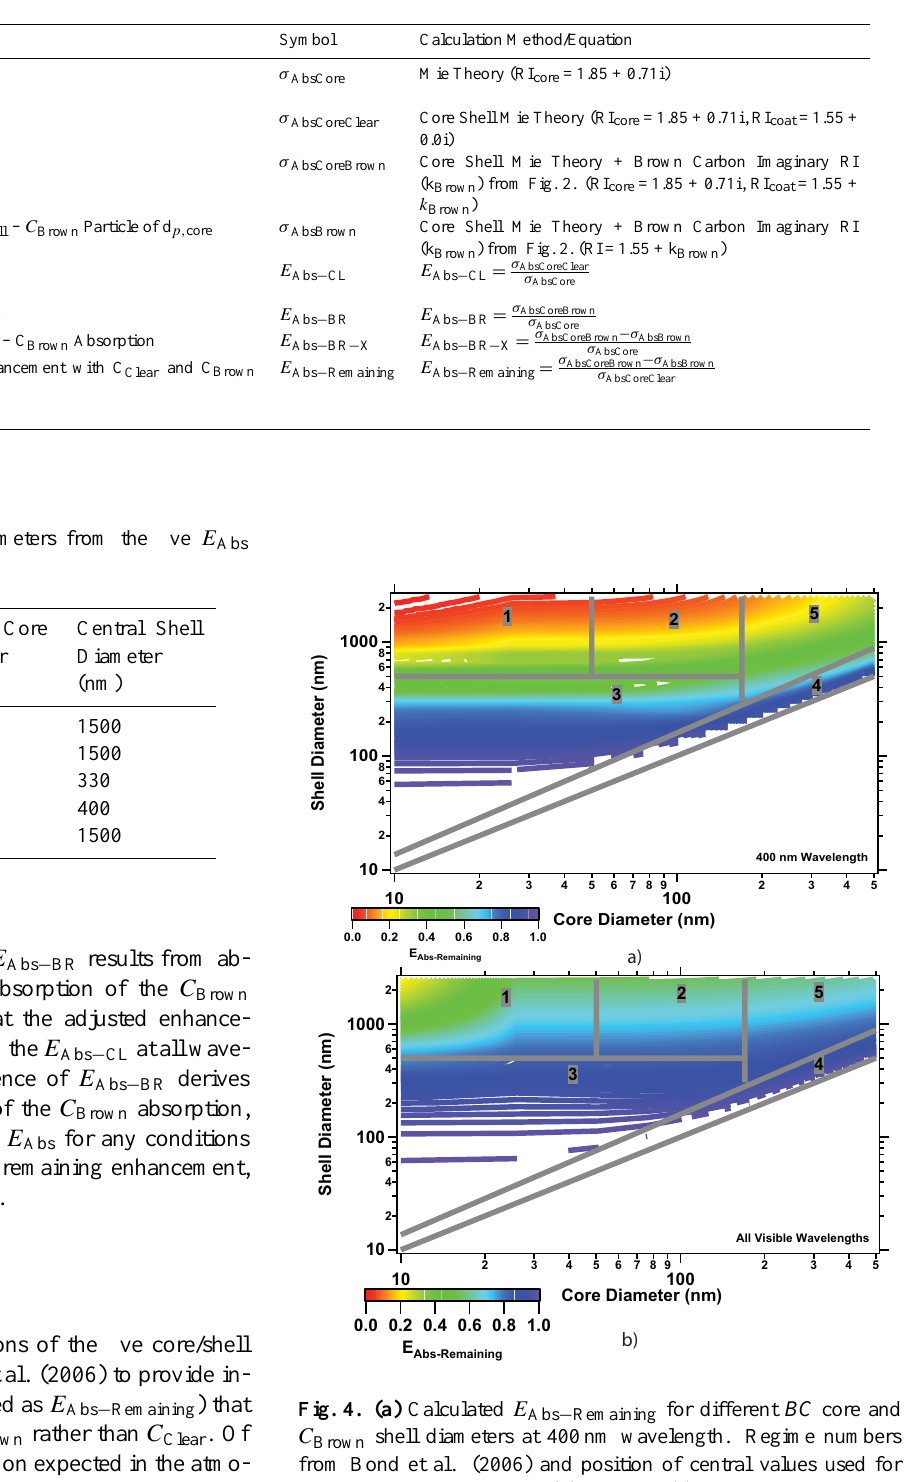
Table 1. Parameter descriptions.